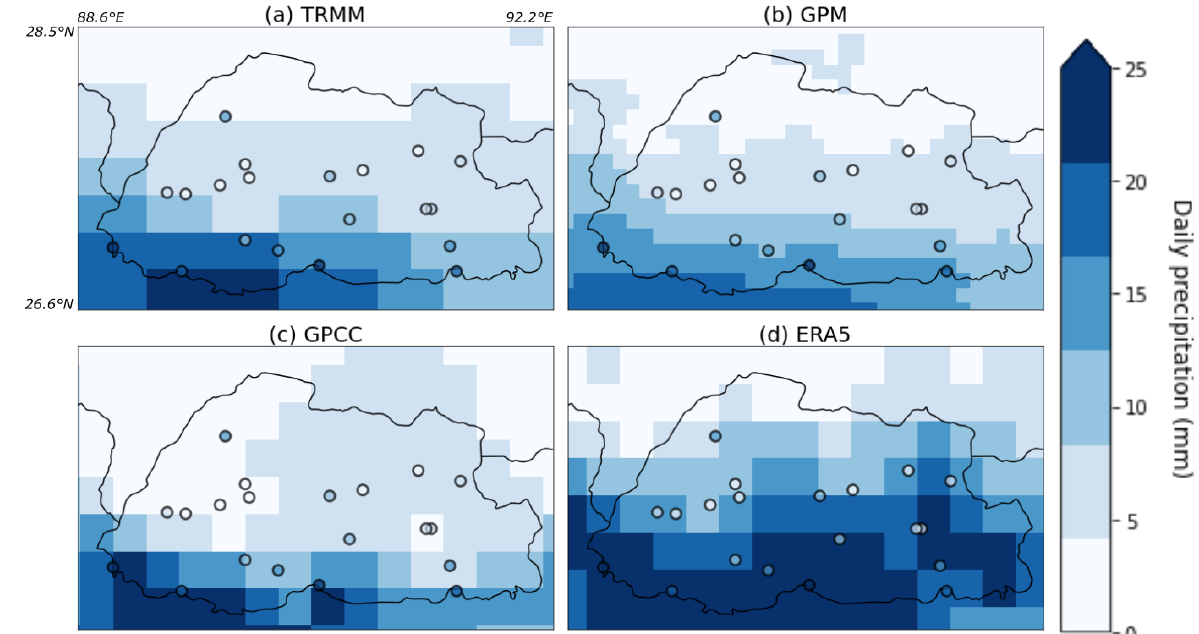
Figure 4. Mean precipitation (mm/day) during the monsoon season (June to September) based on the years 2012 to 2019. ( a ) TRMM; ( b ) GPM; ( c ) GPCC; and ( d ) ERA5 precipitation compared with daily weather station precipitation data displayed in the